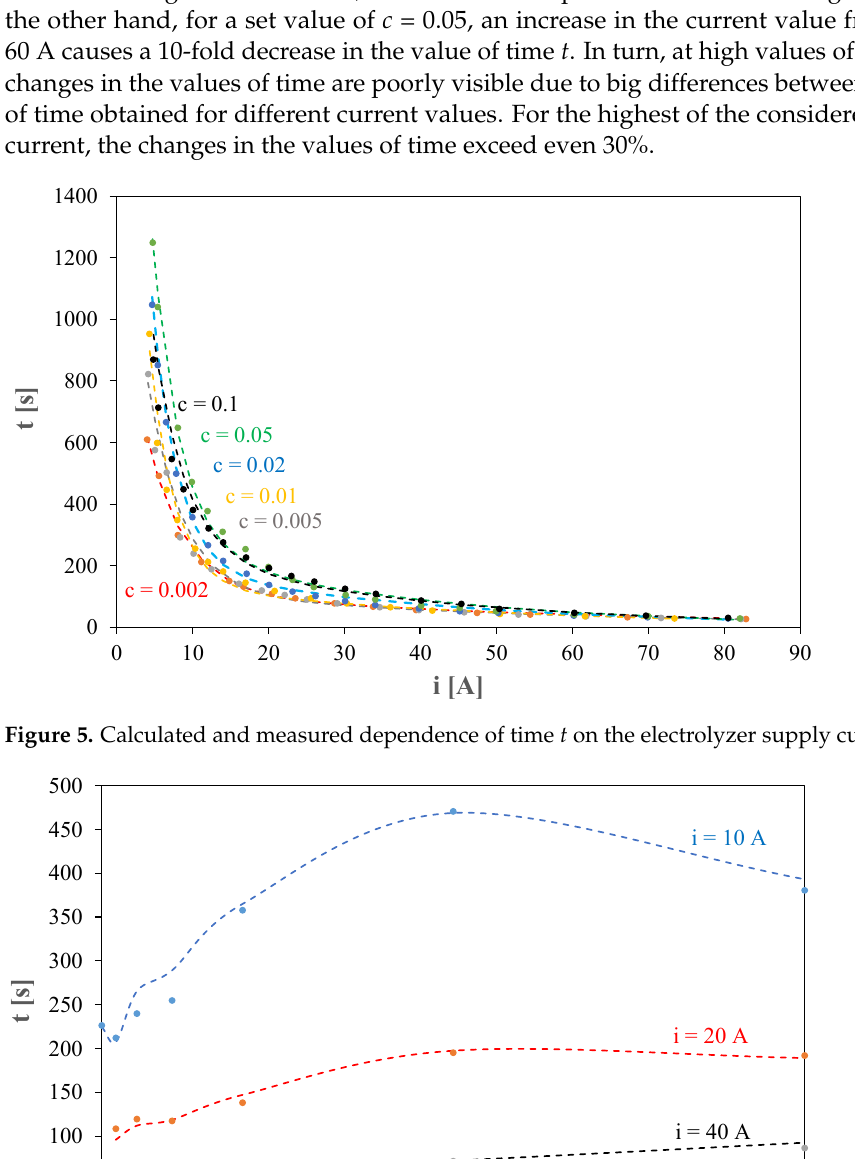
By analyzing Figure 6, it can be concluded that the highest hydrogen generation rate is